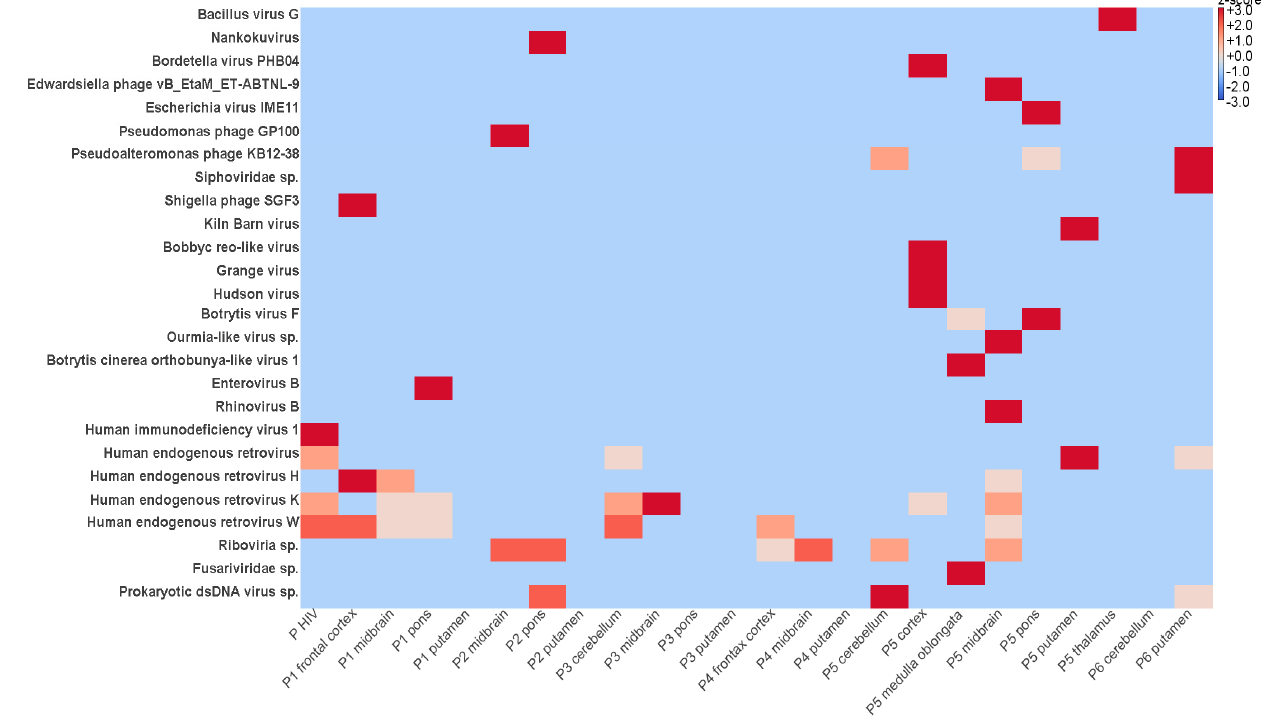
Figure 4. Heat map visualizing the most abundant virus species in each brain area from six patients with PEP. The brain regions are listed on the X axis. The virus species are presented on the Y axis. The map is color-coded based on row z-scores; P HIV—brain from HIV infected patient used as positive control.